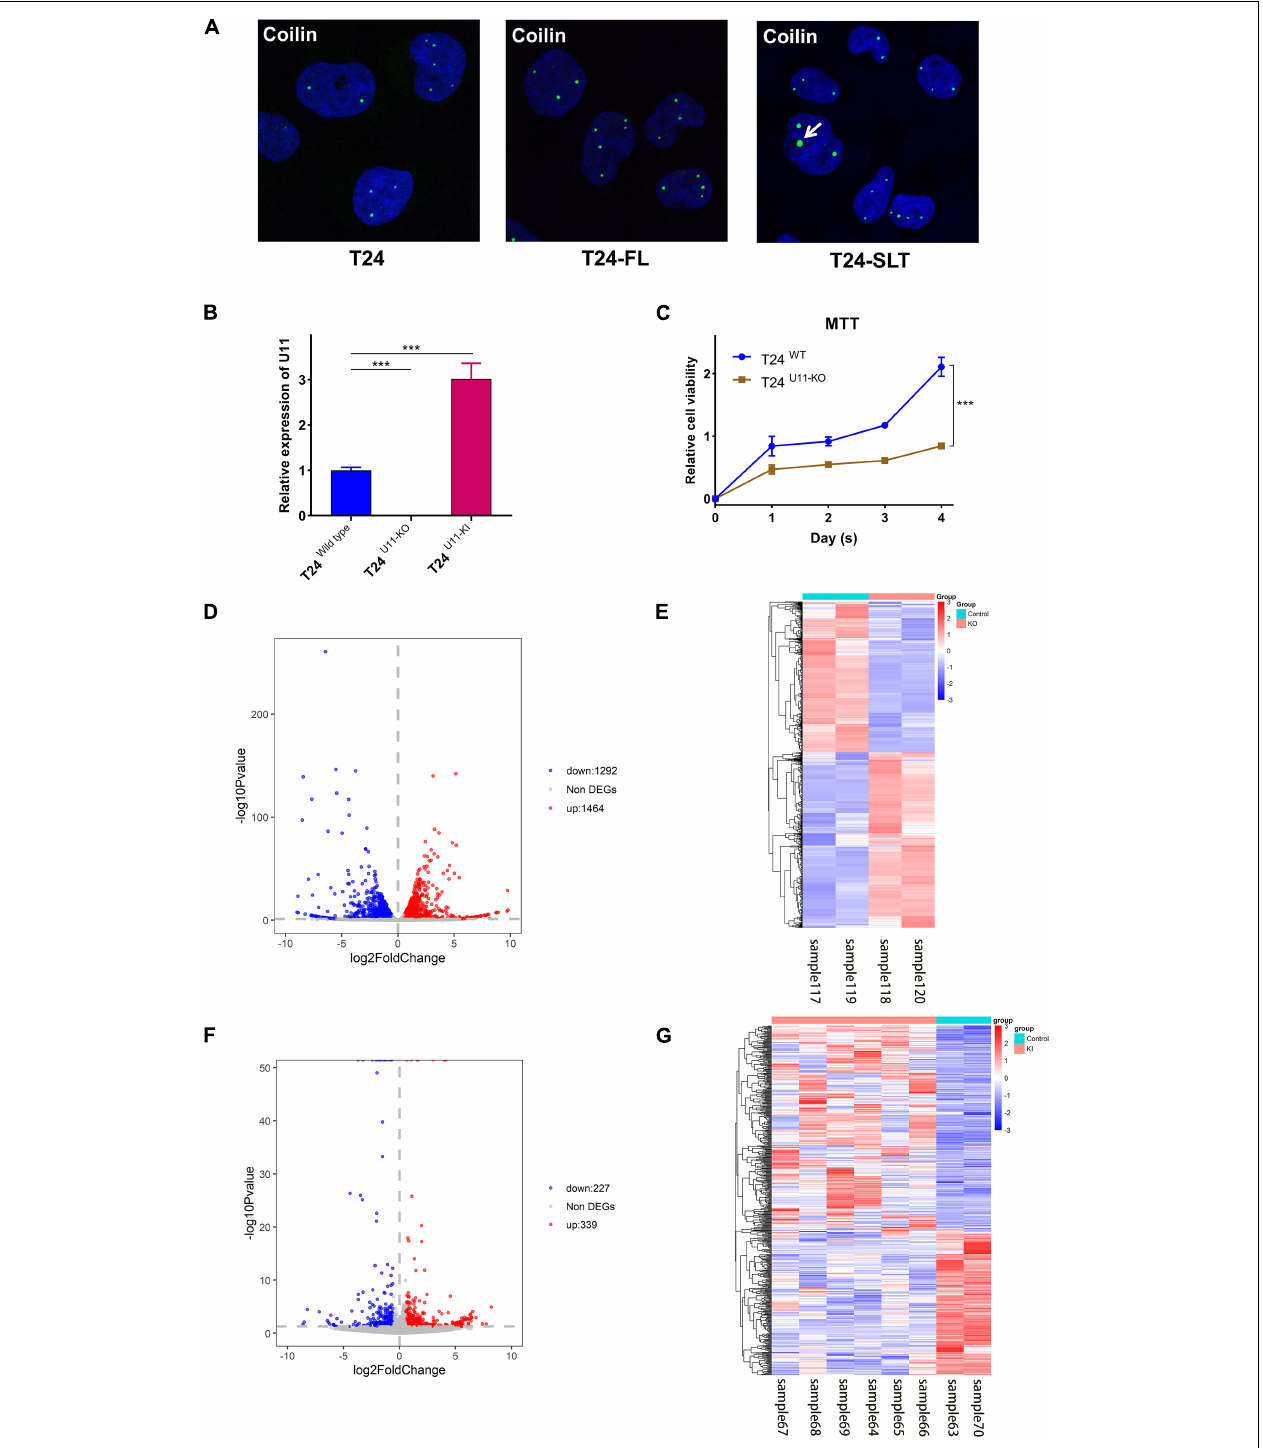
FIGURE 1 | Construction of T24 U11 − KO and T24 U11 − KI cell lines and DEGs analysis of T24-related cell lines. (A) Immunofluorescence of Coilin in T24, T24-FT, T24-SLT cell lines. (B) The expression levels of U11 in T24 U11 − KO and T24 WT cell lines. (C) Cell viability of T24 U11 − KO and T24 WT cell lines. (D) Volcano plot for differentially expressed genes between T24 U11 − KO and T24 WT cell lines. (E) Heatmap for differentially expressed genes between T24 U11 − KO and T24 WT cell lines. (F) Volcano plot for differentially expressed genes of between T24 U11 − KI and T24 WT cell lines. (G) Heatmap for differentially expressed genes of between T24 U11 − KI and T24 WT cell lines. Differential expressed genes (DEGs): P -value < 0.05 and | Fold change| ≥ 1.5. *** P < 0.001.